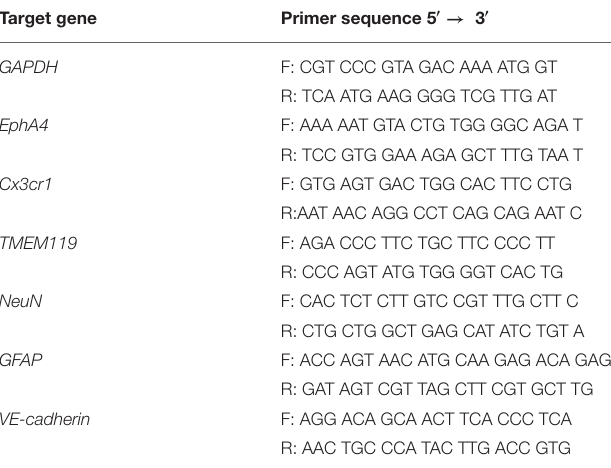
TABLE 2 | Sequence of primers used in